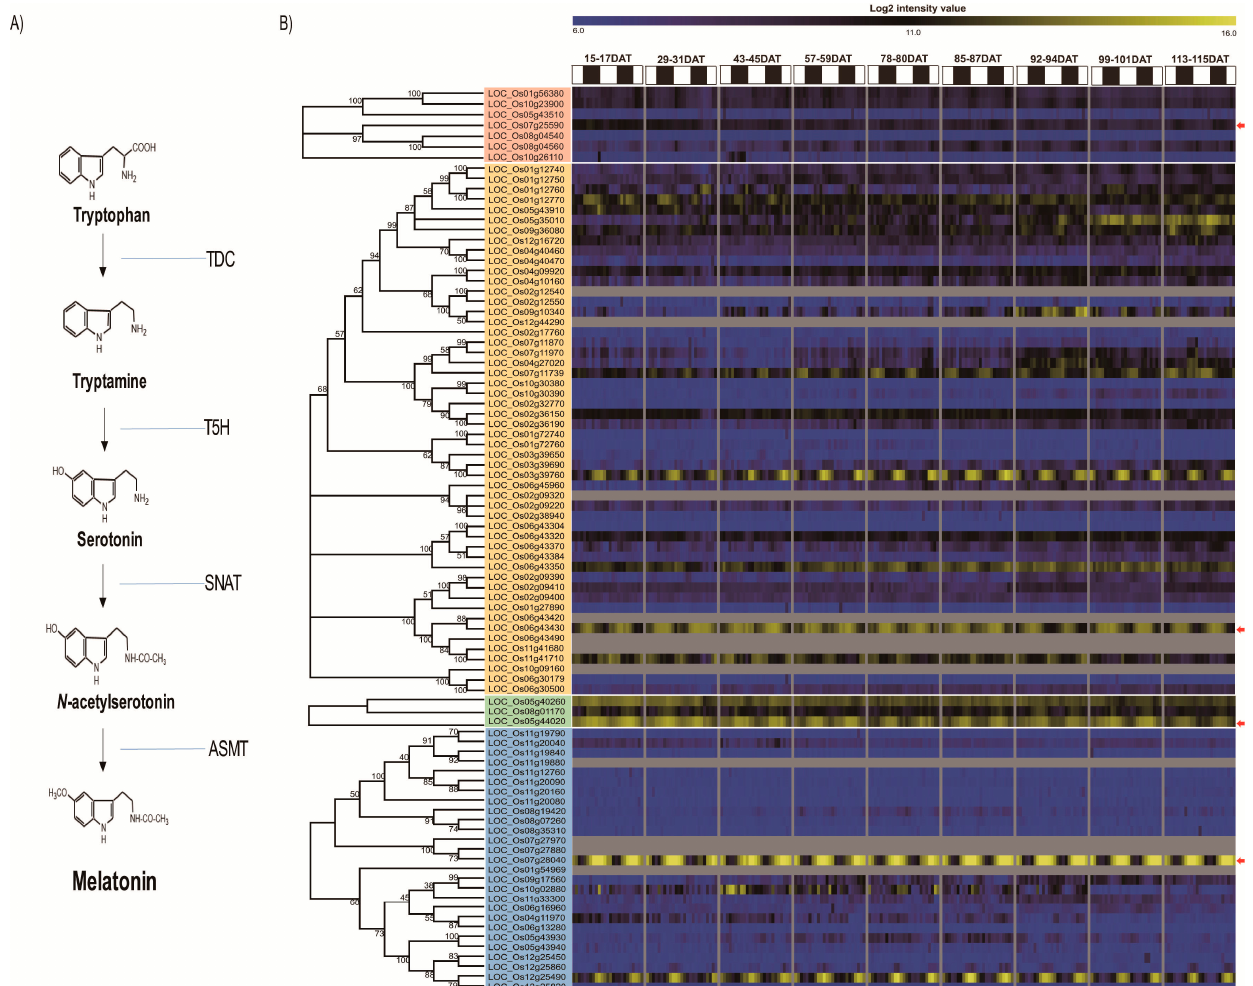
Figure 1. The standard pathway of melatonin biosynthesis from tryptophan in plants ( A ). Tryptophan decarboxylase (TDC); Tryptamine 5-hydroxylase (T5H); Serotonin N-acetyltransferase (SNAT); N-acetylserotonin O-methyltransferase (ASMT). Diurnal expression patterns of melatonin biosynthesis genes in rice, as assessed using Agilent 44k array data over the entire growth stage ( B ). Blue—low level of log2 intensity value; Yellow—high level of log2 intensity value.